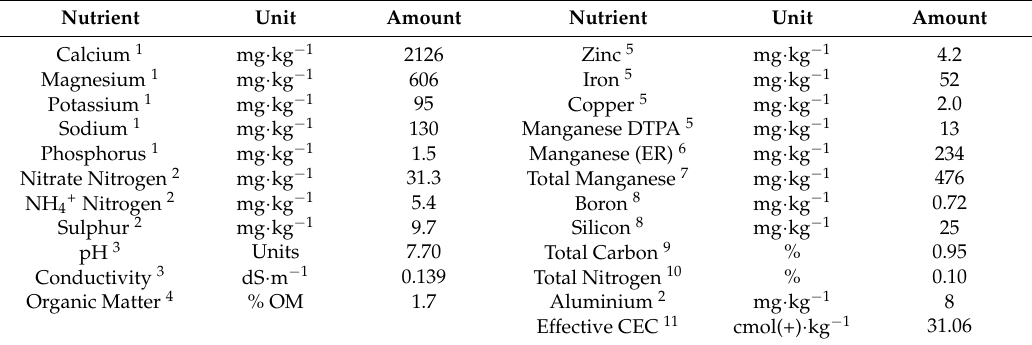
Table 1. Soil properties and nutrient content at a depth of 0–10 cm at the experimental field